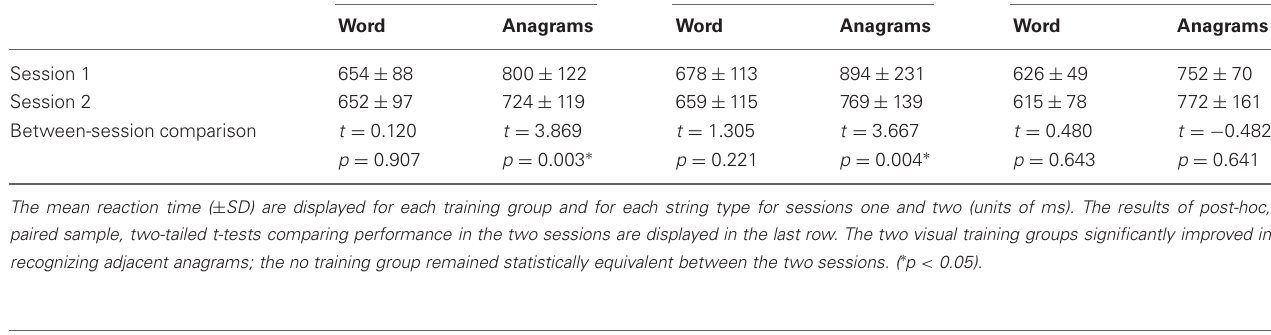
Table 3 | Mean accuracy ( ± SD) on a lexical decision task by type, group, and